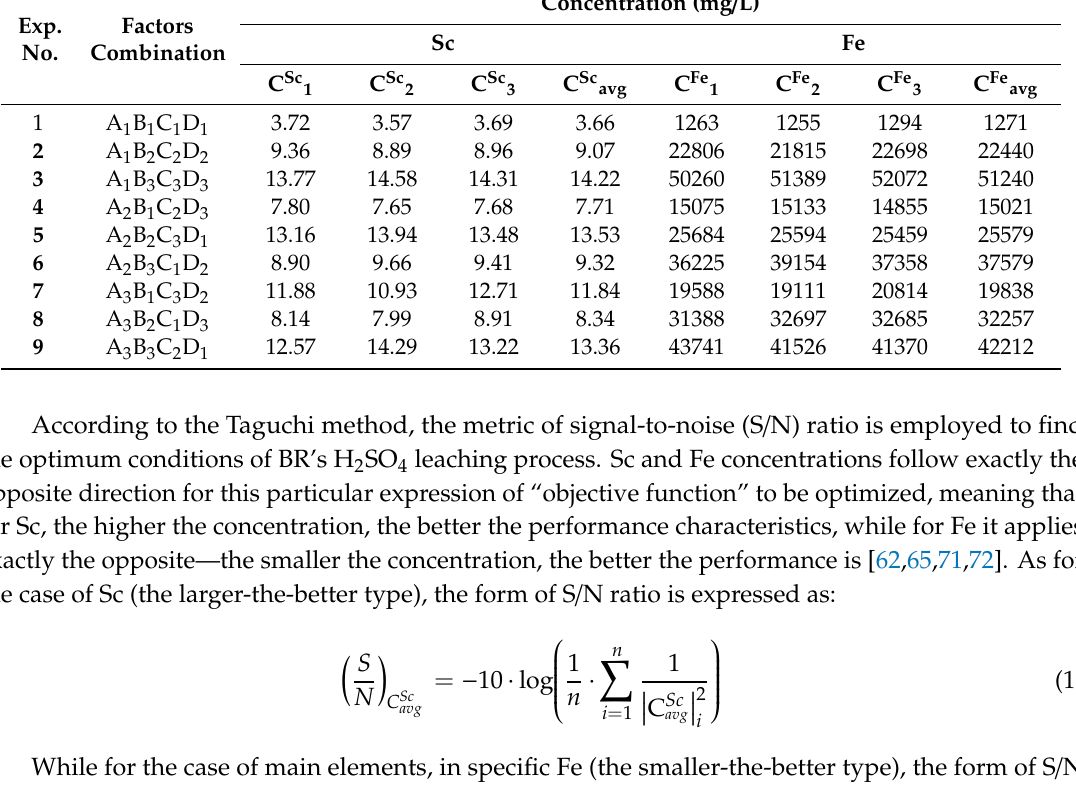
Table 3. Measurements of Sc and Fe concentrations for the corresponding factor combinations of the L 9 (3 4 ) experimental plan.